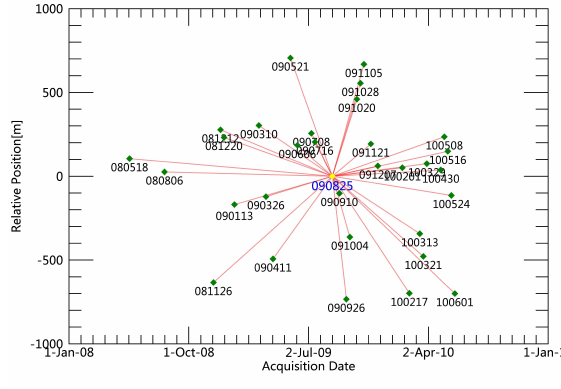
Figure 3. The spatio-temporal baseline of 32 Cosmo-SkyMed interferometric